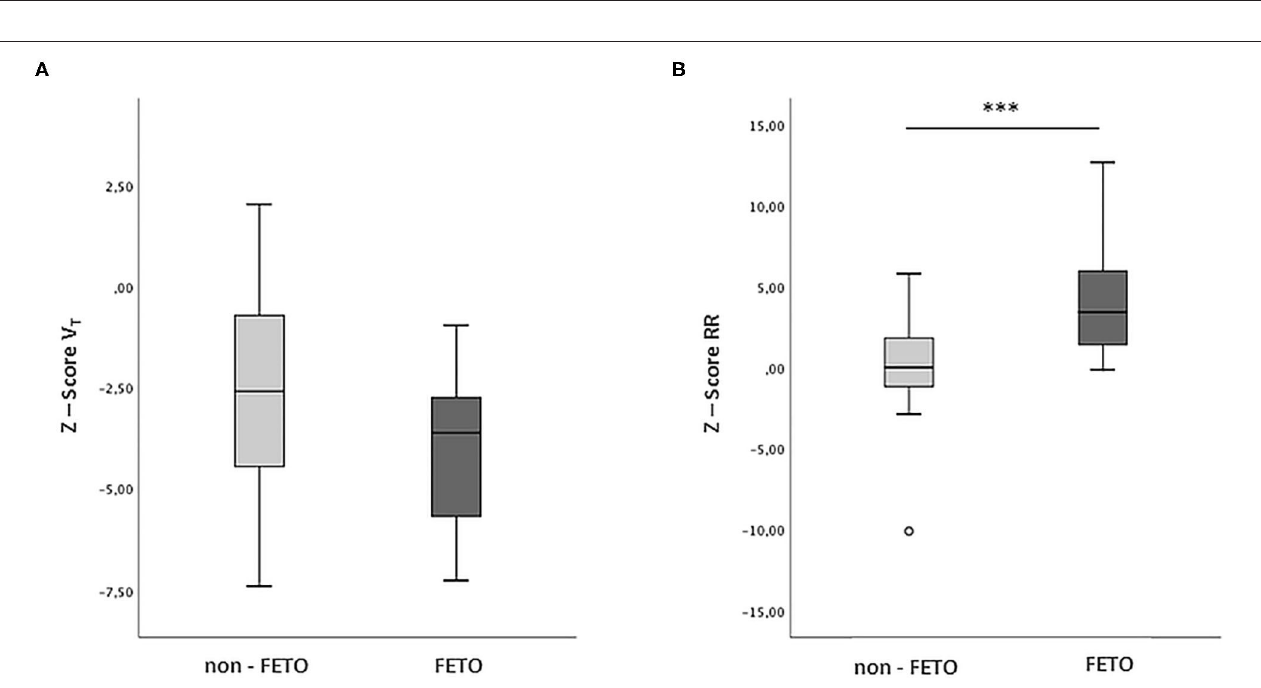
FIGURE 6 | V T and RR in FETO and non-FETO groups. Boxplot showing the distribution of the respiratory parameters between FETO ( n = 11) and non-FETO ( n = 32) patients. Student’s T -Test was performed to compare the two groups. (A) Z Score Tidal Volume (V T ), p = 0.070. (B) Z-Score Respiratory Rate (RR), *** p < 0.001.